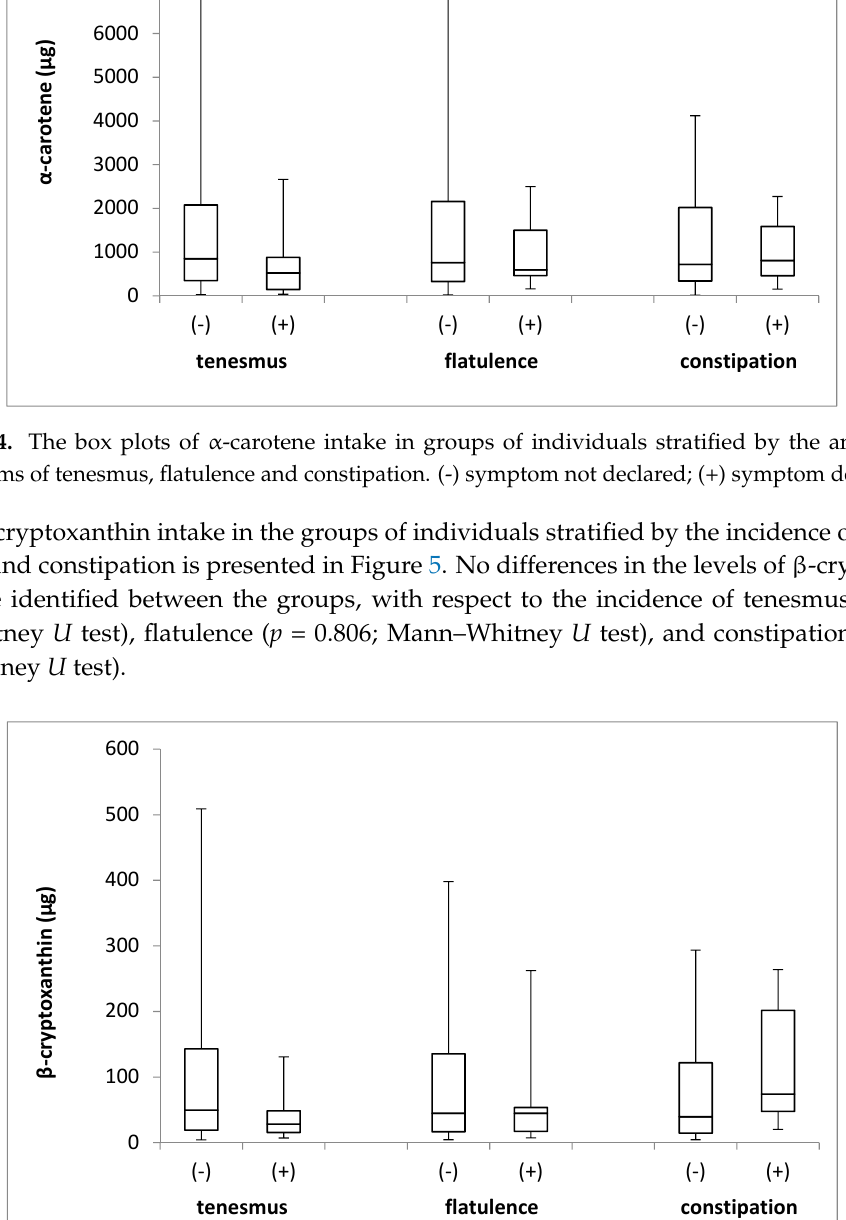
Figure 5. The box plots of β -cryptoxanthin intake in groups of individuals stratified by the analyzed symptoms of tenesmus, flatulence and constipation. (-) symptom not declared; (+) symptom declared. The lycopene intake in the groups of individuals stratified by the incidence of tenesmus, flatulence, and constipation is presented in Figure 6. No differences in the levels of lycopene intake were identified between the groups, with respect to the incidence of tenesmus ( p = 0.290; Mann– Whitney U test), flatulence ( p = 0.216; Mann–Whitney U test), and constipation ( p = 0.785; Mann– Whitney U test).